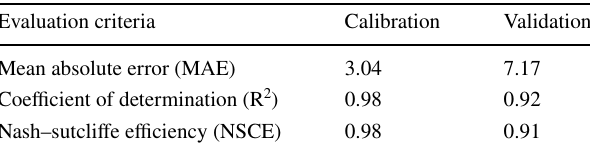
Table 1 Summary of performance of random forest models Evaluation criteria